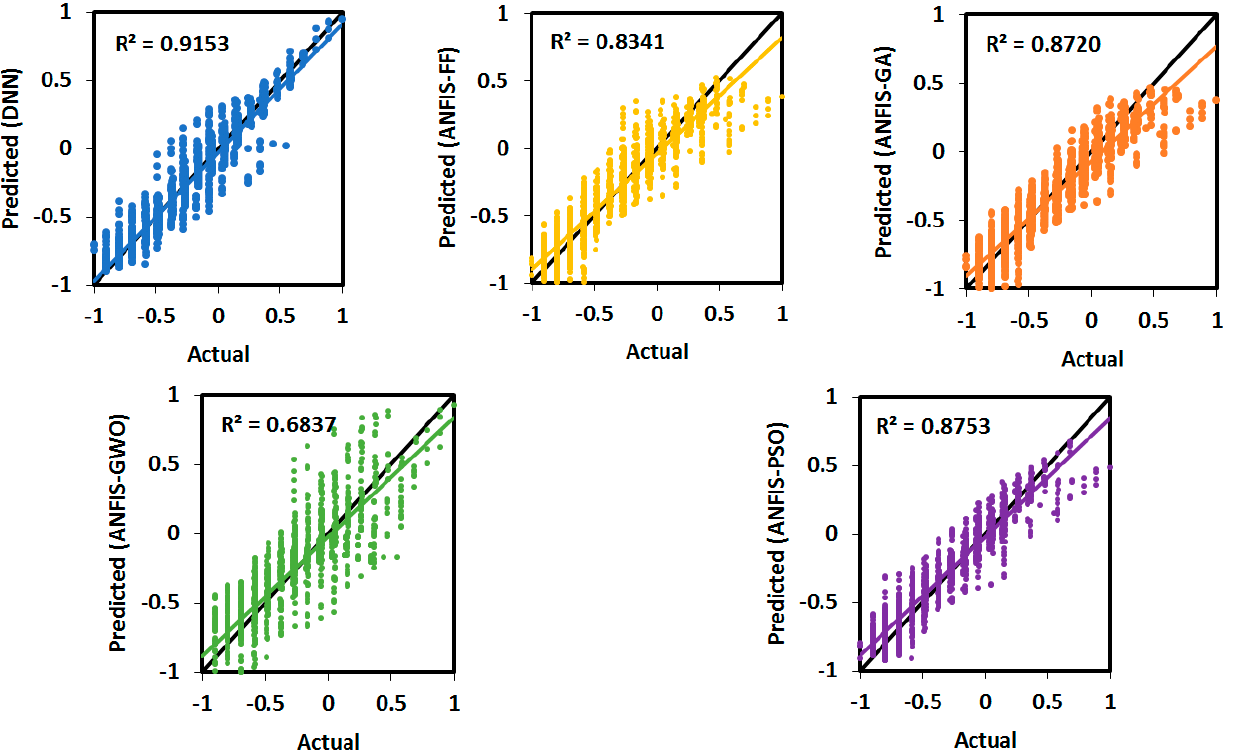
Figure 8. Illustration of actual and predicted strain in lateral ( x ) dimension (Training phase).